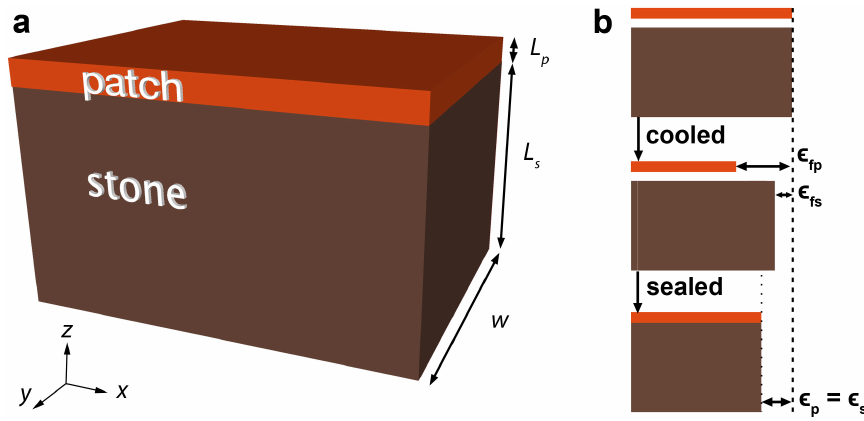
Figure 2. ( a ) Schematic of the patch layer on top of the stone substrate; ( b ) Illustration of the thermal expansion mismatch between the two